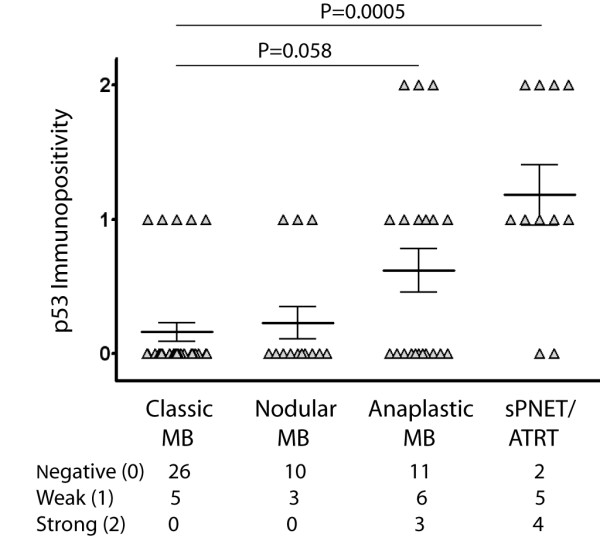
A statistically significant increase in p53 immunopositivity in AT/RT and sPNET Most classic and nodular medulloblastoma (MB) contained no p53 immunopositive cells. In contrast, p53 positive cells were present in many anaplastic MB, supratentorial primitive neuroectodermal tumors (sPNET) and atypical teratoid rhabdoid tumors (ATRT). Triangles represent individual tumors with negative (0), weak (1) or strong (2) p53 immunostaining. Bars represent the mean and standard error of the mean. The increase in p53 immunopositivity in the sPNET/ATRT category as compared to classical MB was statistically significant (Mann Whitney test).